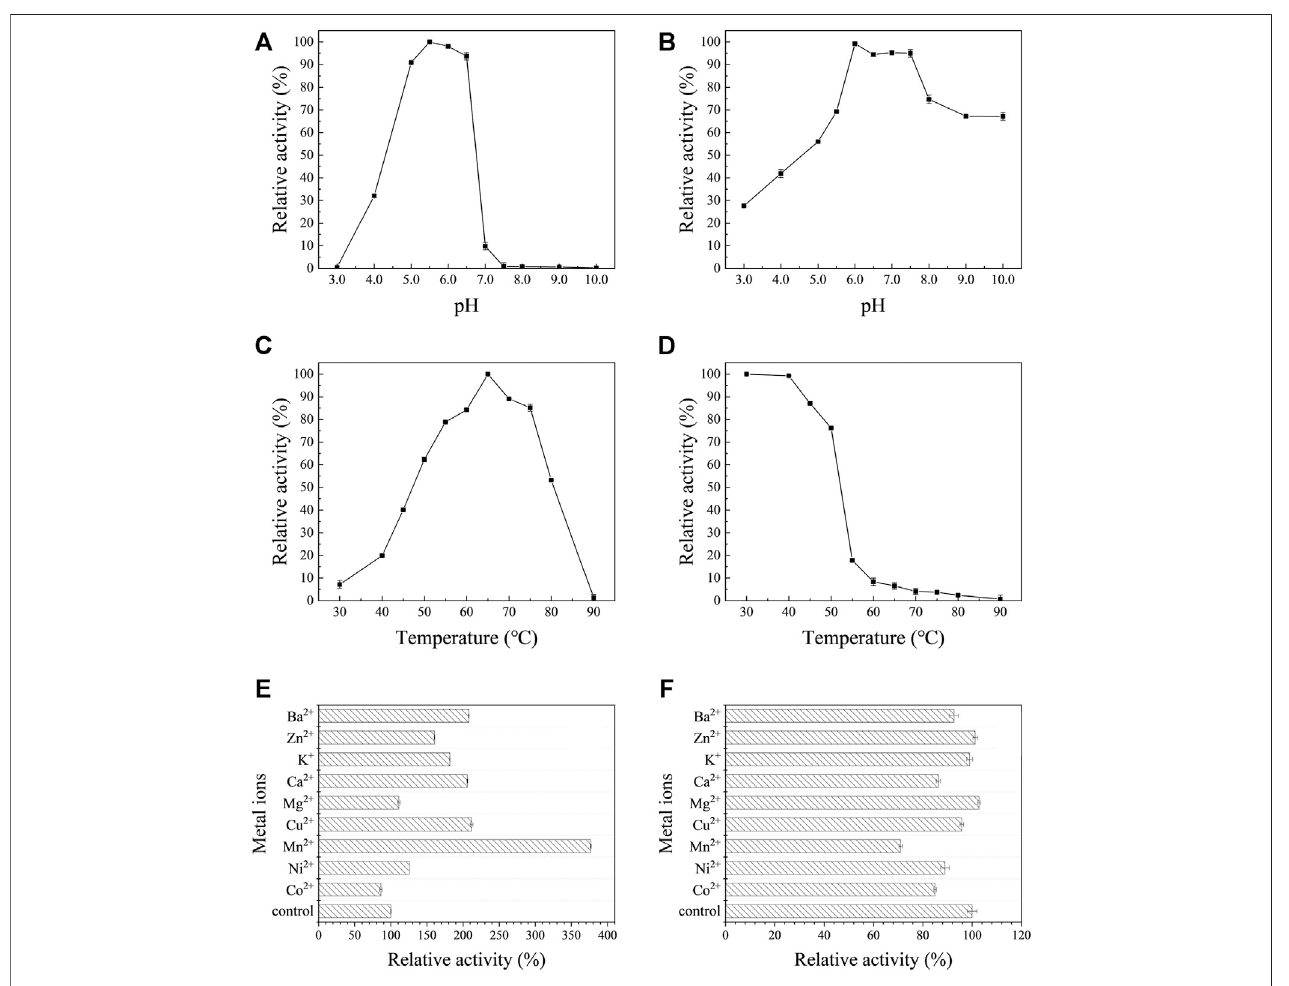
FIGURE 3 | The biochemical characterization of AoNagase, optimal pH (A) , pH stability (B) , optimal temperature (C) , thermostability (D) and the effects of metal ionsonAoNagaseactivity withchitosan (E) andcolloidalchitin (F) assubstrat.Theresultsweretheaverageof3sets ofparallelsamples,andthestandarddeviation(SD) was taken as the error